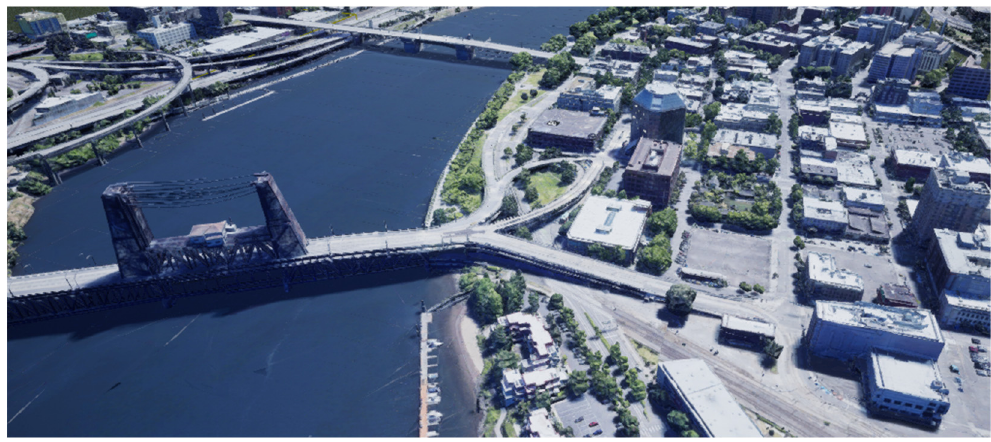
Figure 7. Unreal Engine 4 reproduction of the Portland heliport and its surroundings.